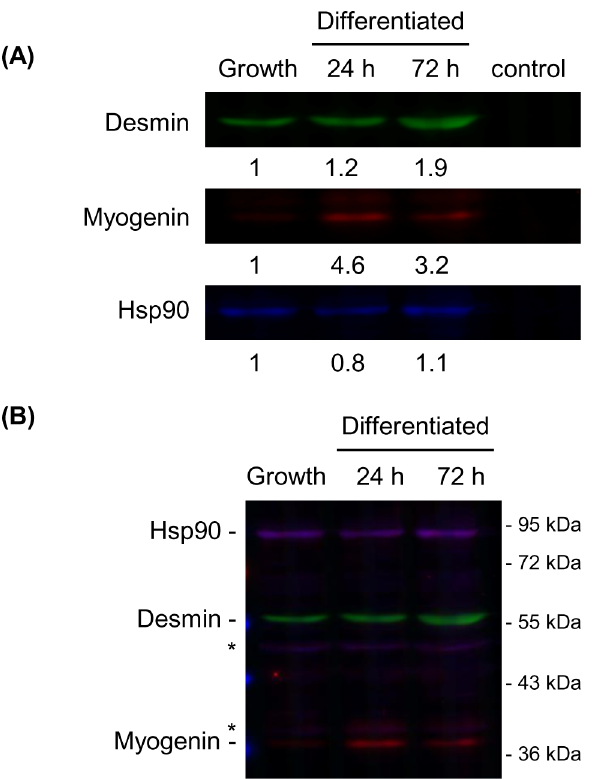
Fig 4. Practical application of the fluorescence detection method to analyze multiple proteins. (A) Joined images of fluorescent western blot of C2C12 myoblast cells under normal growth and differentiated conditions. Control lane contained sample buffer as negative control. Desmin (green), myogenin (red), and Hsp90 (blue) are displayed as false colors. Relative integrated density values normalized to the values at the growth condition are shown. Exposure time was 1/40 seconds in desmin, 1/8.5 seconds in myogenin and 1/5 seconds in Hsp90. (B) Merged images described in (A). Asterisk shows nonspecific band.